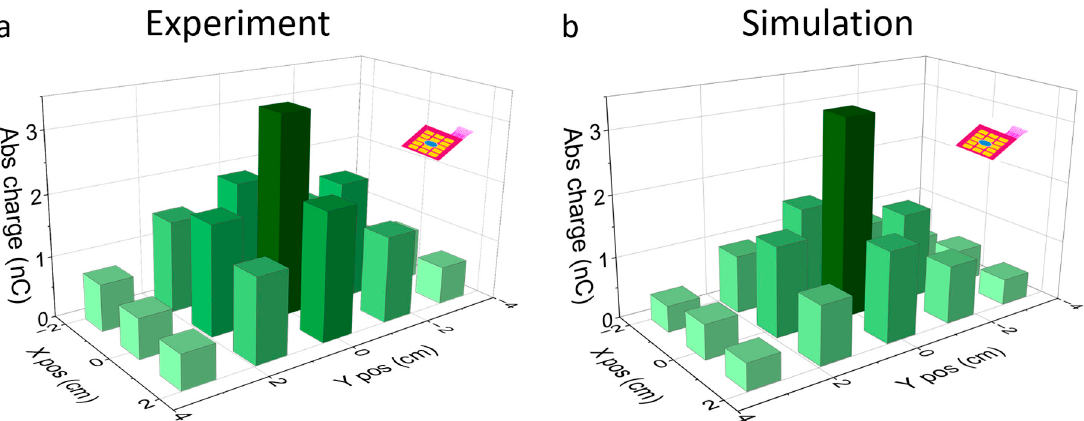
Figure 7. ( a ) Output of a sensor matrix when excited by a 1 cm 2 stamp applying 90 N at 50 µm/s. ( b ) Simulated sensor matrix output for a 90 N load applied on top of the floor tile domain spread in a circular 1 cm 2 area. In both cases the crosstalk is present, although its magnitude is underestimated in the simulation. For this FEM simulation, we used a K ef f value of 150 N/cm 3 . This value showed the best agreement for the central pixel.